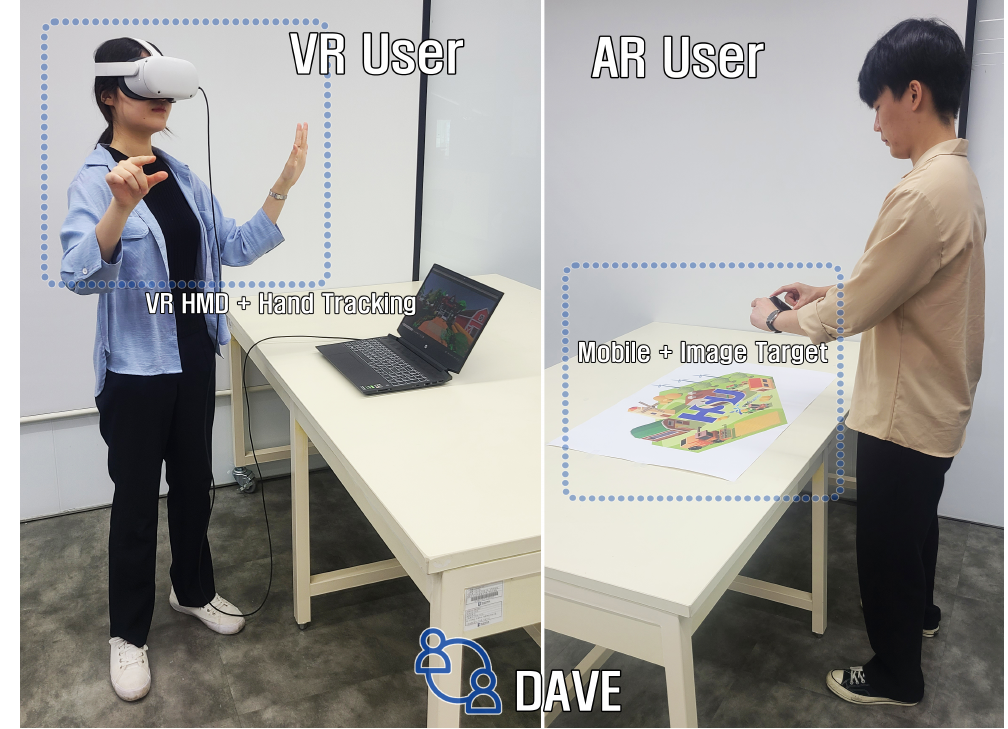
Figure 7. Configuration of the DAVE experience environment where VR and AR users